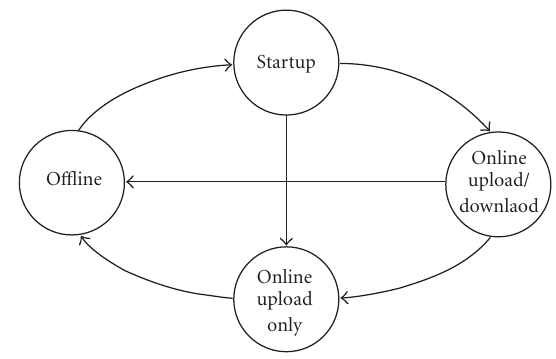
Figure 7: The state diagram of a